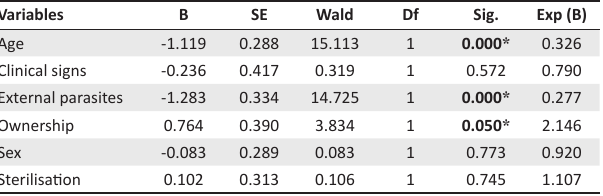
TABLE 2: Wald’s chi-square results from the univariable logistic regression models.